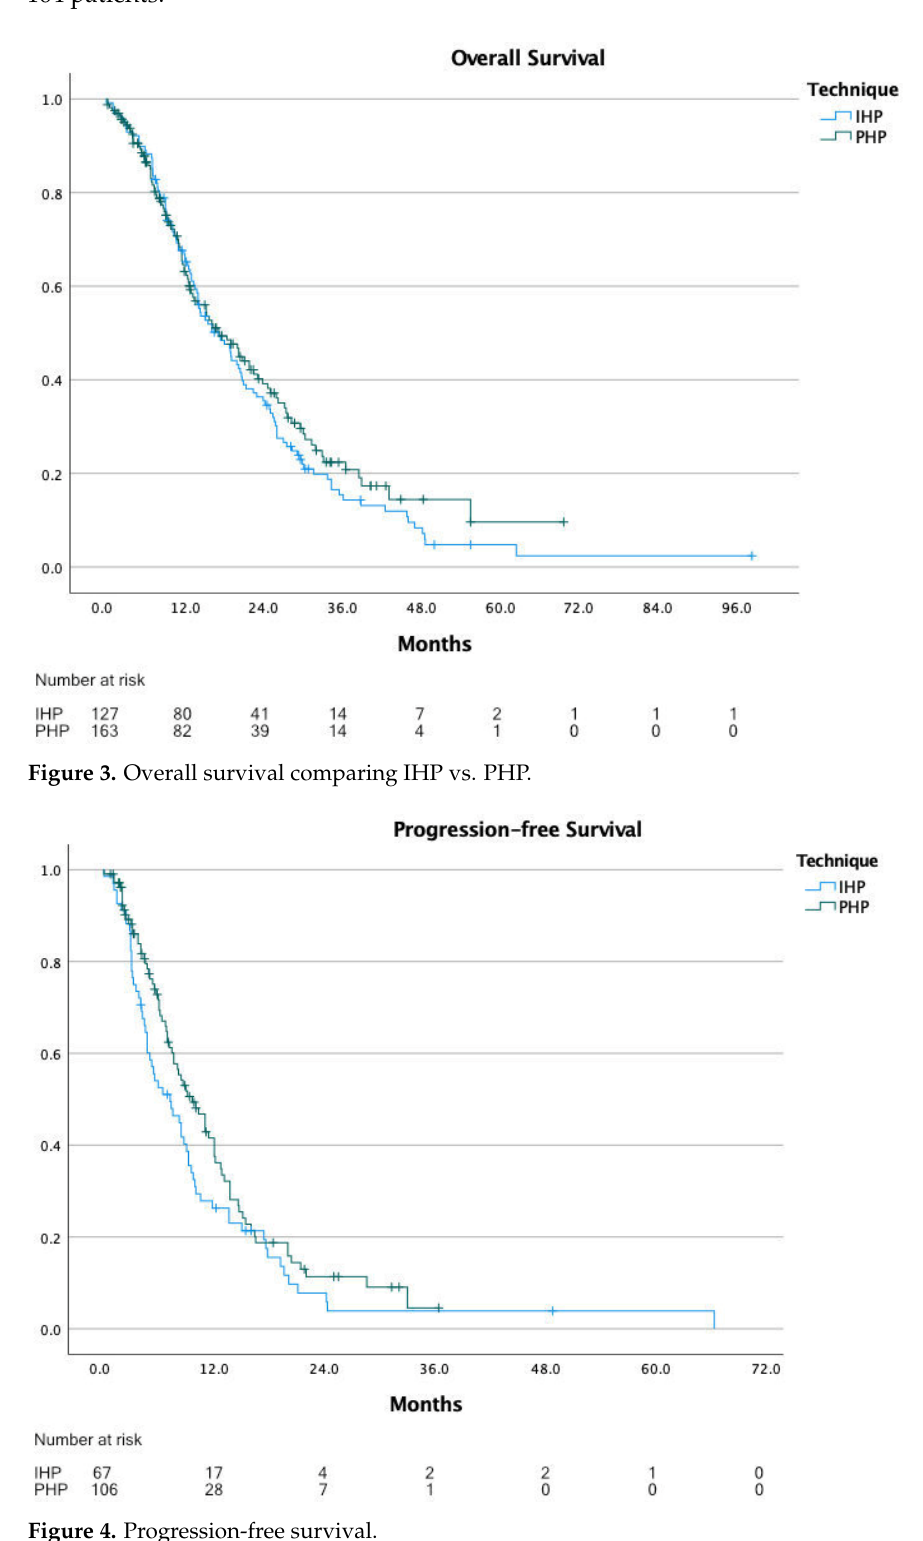
Figure 5. Hepatic progression ‐ free survival. 4. Discussion The calculated OS data show that there is no difference between IHP and PHP for patients with liver metastases from uveal melanoma in the long term, but that patients have a significantly lower risk of complications and mortality following PHP. All three studies reporting on IHP excluded patients with extra ‐ hepatic disease, whereas four out of the five studies on PHP included patients with extra ‐ hepatic disease if it was either “limited” or the patients had a liver ‐ dominant metastasizing pattern. The study that included most patients with extra ‐ hepatic disease (12 out of 29 patients) found no difference in OS between patients with or without these extra ‐ hepatic metastases at the time of PHP [61]. One study on IHP excluded patients with a tumor burden of more than 50% of the liver volume [63]. In another study, these patients were excluded in the last of three periods, because tumor burden >50% was associated with higher mortality for the patients included in the first two periods [58]. For PHP, only one study mentions a maxi ‐ mum tumor burden of 60% [64,65]. Of all patients included in the IHP studies, the majority did not receive any prior treatment for their liver metastases. In at least two out of the five articles on PHP, most of the patients had prior treatment for their liver metastases. All the previously mentioned exclusion criteria, or characteristics of the included patients, could imply a selection bias from which survival rates after IHP could benefit. Overall survival data could be extracted for all reported patients in the eight included studies. The difference in outcome, when comparing the results of the reported median survival data or from the combined extracted data, shows that the extraction process is of value. Longer OS for PHP was to be expected as repeated procedures are possible and